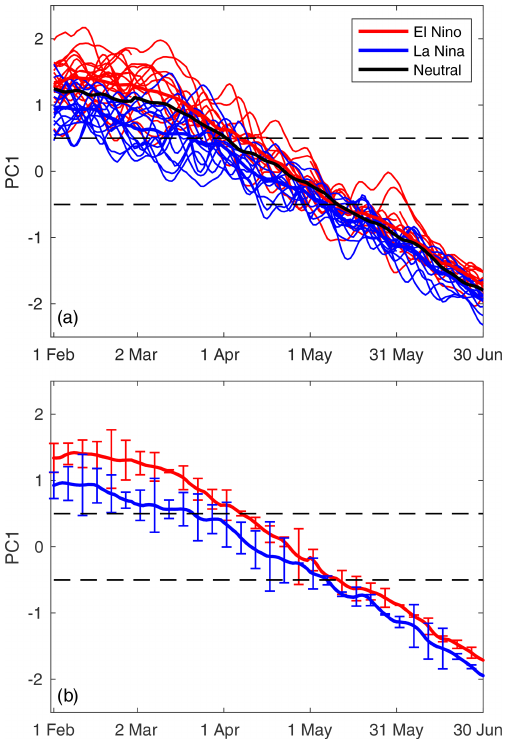
Figure 8. (a) The thin lines show PC1 values (using JRA-55) dur- ing months of La Niña events (blue) and El Niño events (red), with the thick blue (red) line showing the average La Niña (El Niño) pe- riods. The thick black line shows the PC1 average for the remaining neutral months. Panel (b) shows the bootstrapped confidence inter- vals for the mean PC1 values for La Niña events (blue) and El Niño events